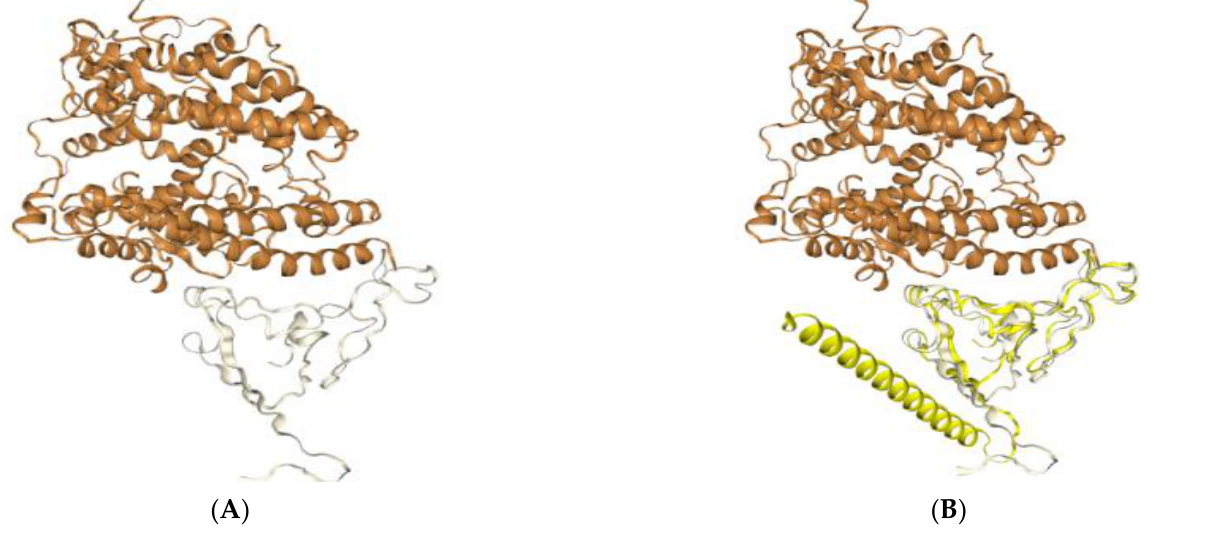
Figure 6. Docking result of the P1-pVIII fusion protein with the ACE2 receptor. The modeled structure is available on the PDB database (PDB ID: 6M0J). ( A ) The structure of the SARS-CoV-2 spike receptor-binding domain (shown in gray) bound to ACE2 with PDB ID 6M0J (brown color). ( B ) Docking result of the Hdock server indicating the possible interaction of the 157 amino acid P1-pVIII fusion protein (shown in yellow) with the ACE2 receptor (docking score −205.4, RMSD: 36.8).